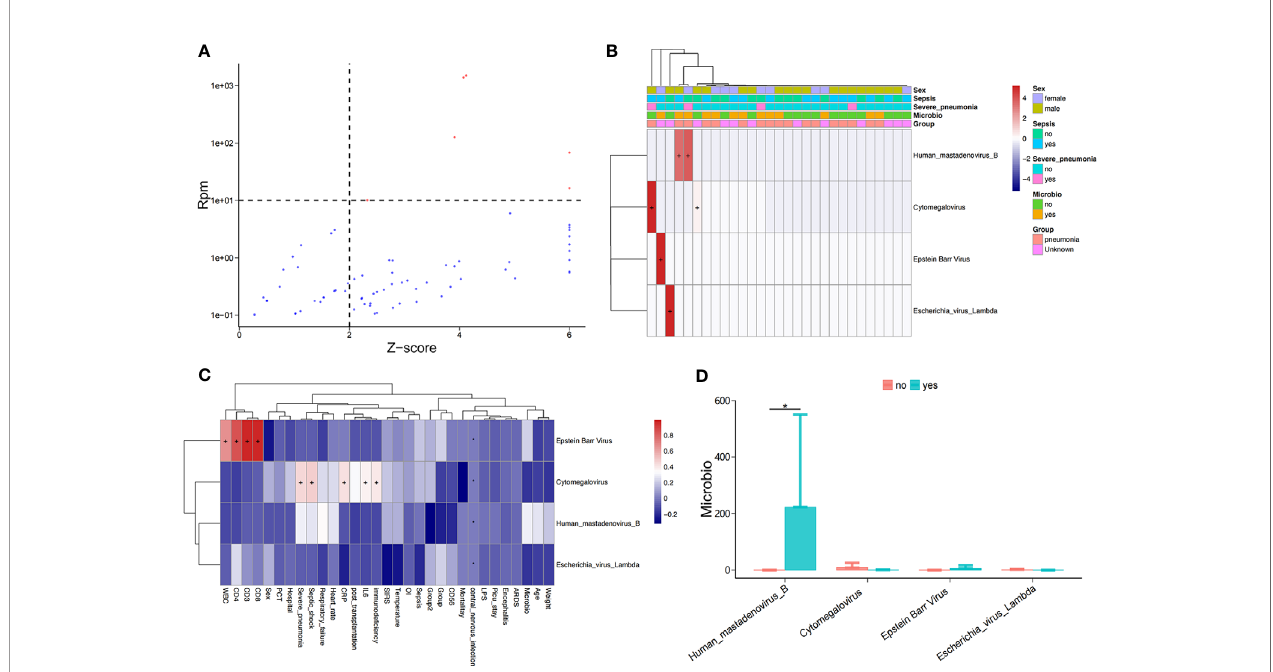
FIGURE 3 | Potential pathogenic viruses in the bloodstream of children with suspected sepsis in PICU. (A) Identi fi ed bloodstream potential pathogenic viruses. (B) Heat map of bloodstream potential pathogenic viruses. (C) Heat map of the correlation between clinical phenotypes and candidate viruses. (D) Compared with children with negative microbial culture, the bloodstream abundance of human mastadenovirus B in children with positive microbial culture was signi fi cantly increased, P < 0.05, Wilcoxon rank-sum test. *P <